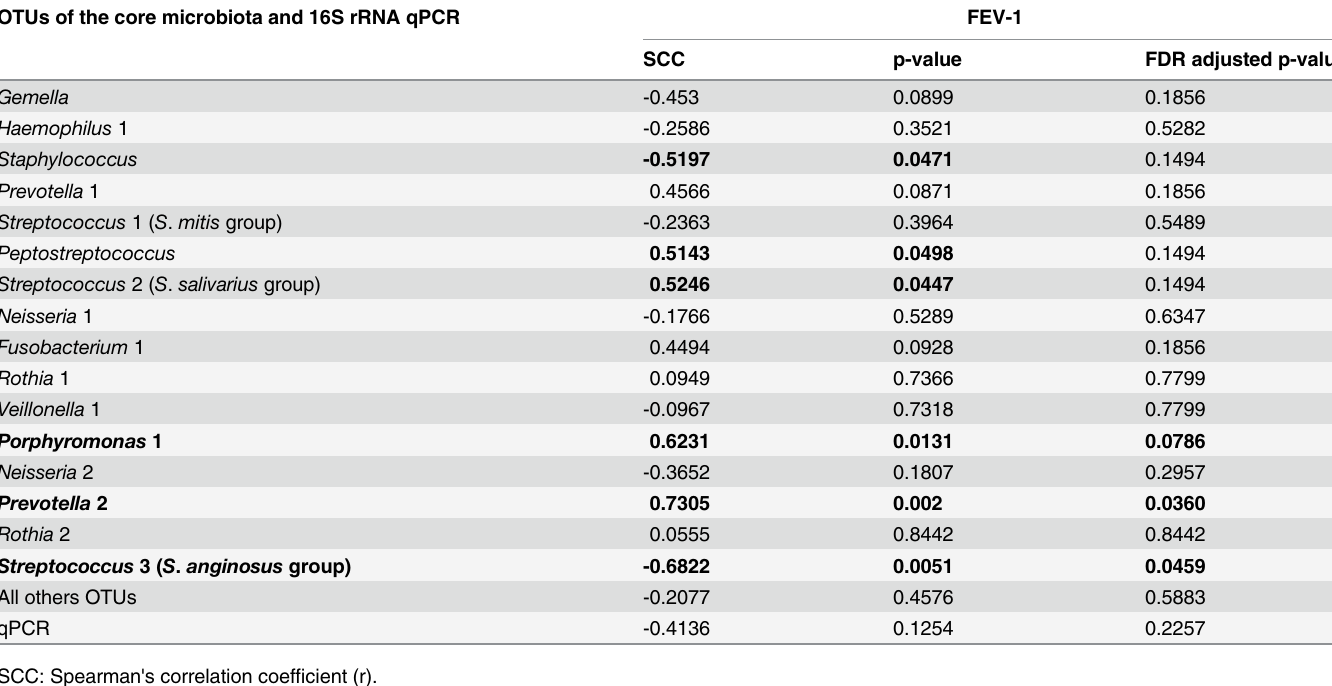
Table 2. Association between relative abundance of OTUs belonging to the major core microbiota and FEV-1 (n = 15 sputum samples). OTUs of the core microbiota and 16S rRNA